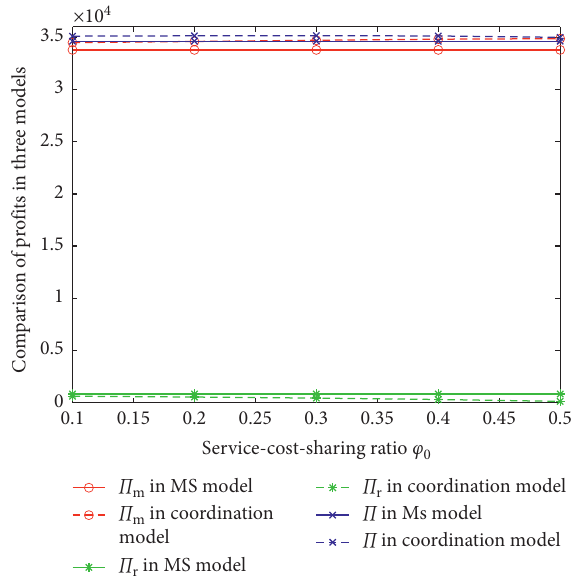
Figure 4: Comparison of MS model and coordination model in Table 1: The sensitivity analysis for seven parameters.